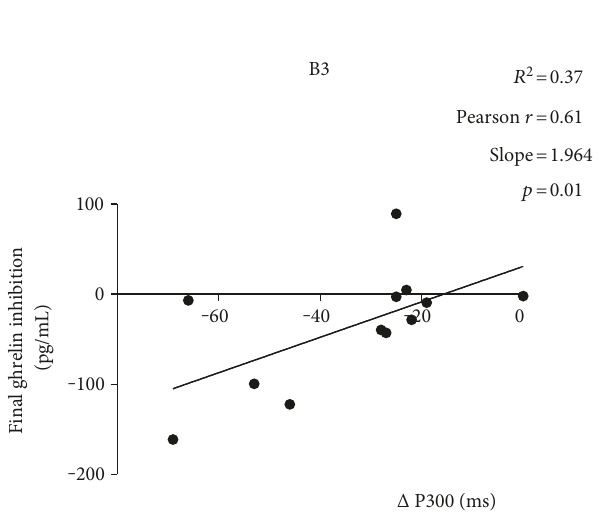
Figure 5: Results of the linear regression analysis between plasma ghrelin inhibition and P300 latency incremental values. The two variables were positively correlated only after consumption of B3 ( r = 0 61 with p = 0 01 ; slope coe ffi cient =1.96pg/mL per ms).